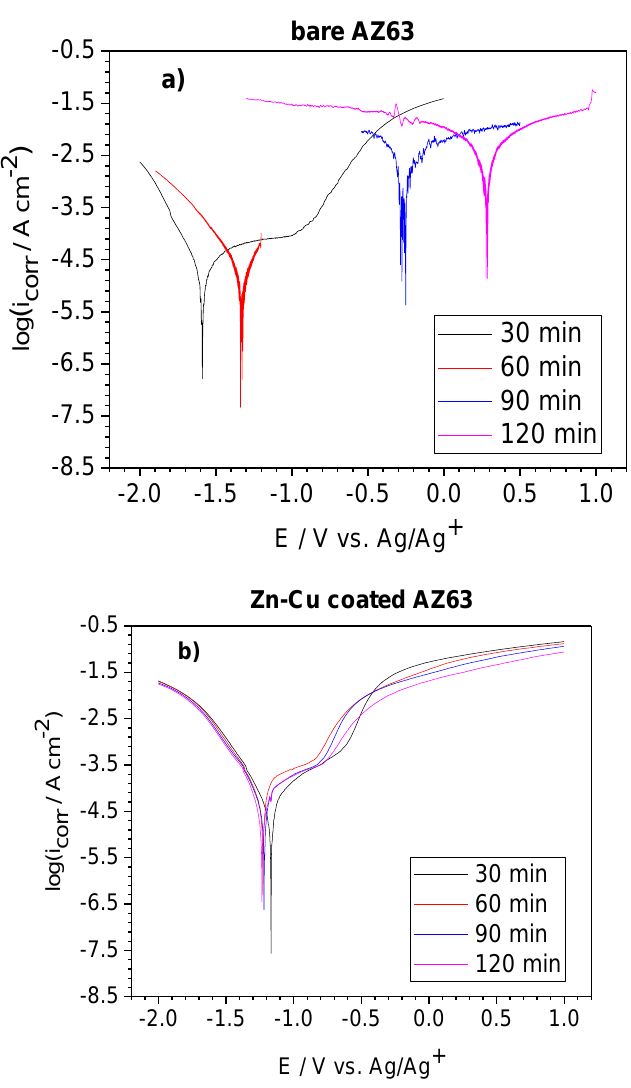
Figure 4. Potentiodynamic polarization curves for ( a ) uncoated AZ63 alloy and ( b ) Zn-Cu coated AZ63 in 3 wt % NaCl solution for 30, 60, 90, and 120 min.